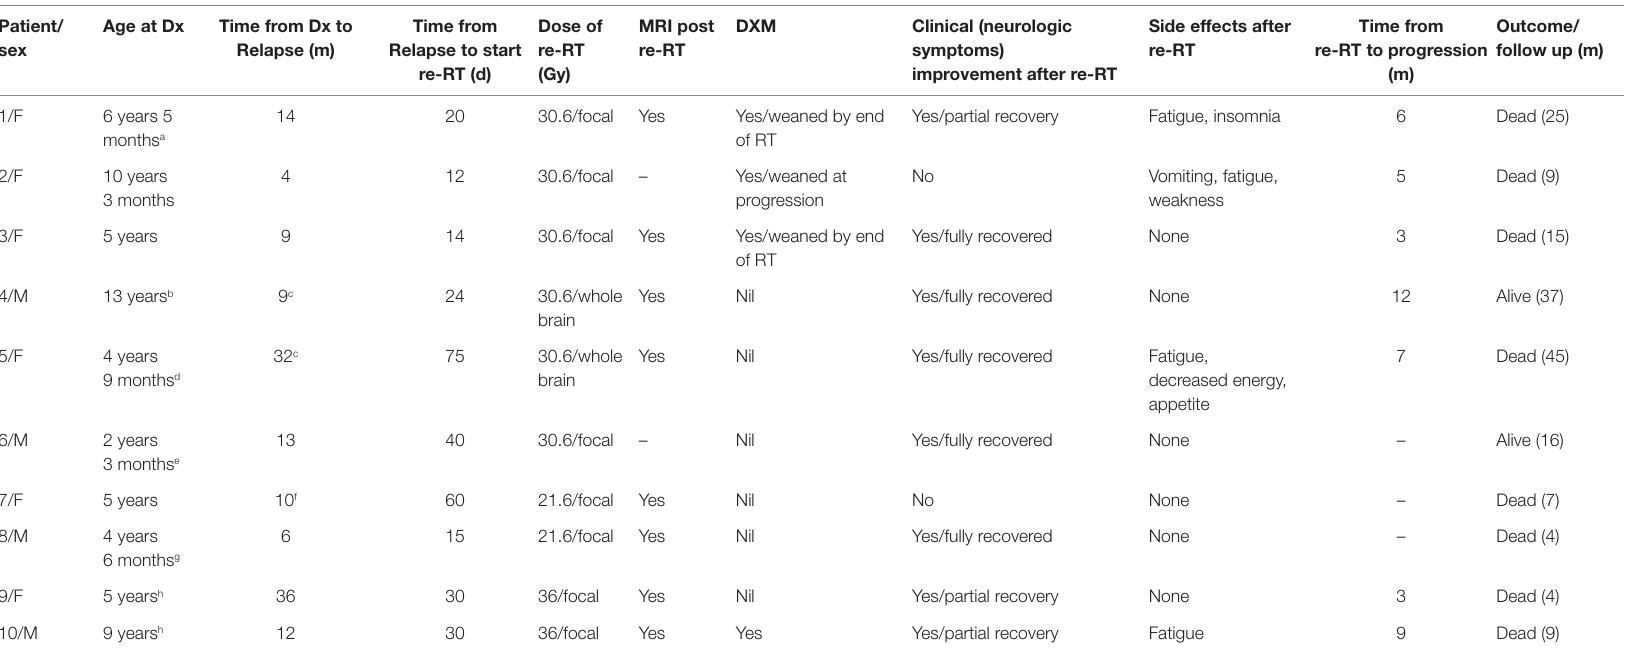
TABLe 2 | Re-irradiation for DiPG (60). Patient/